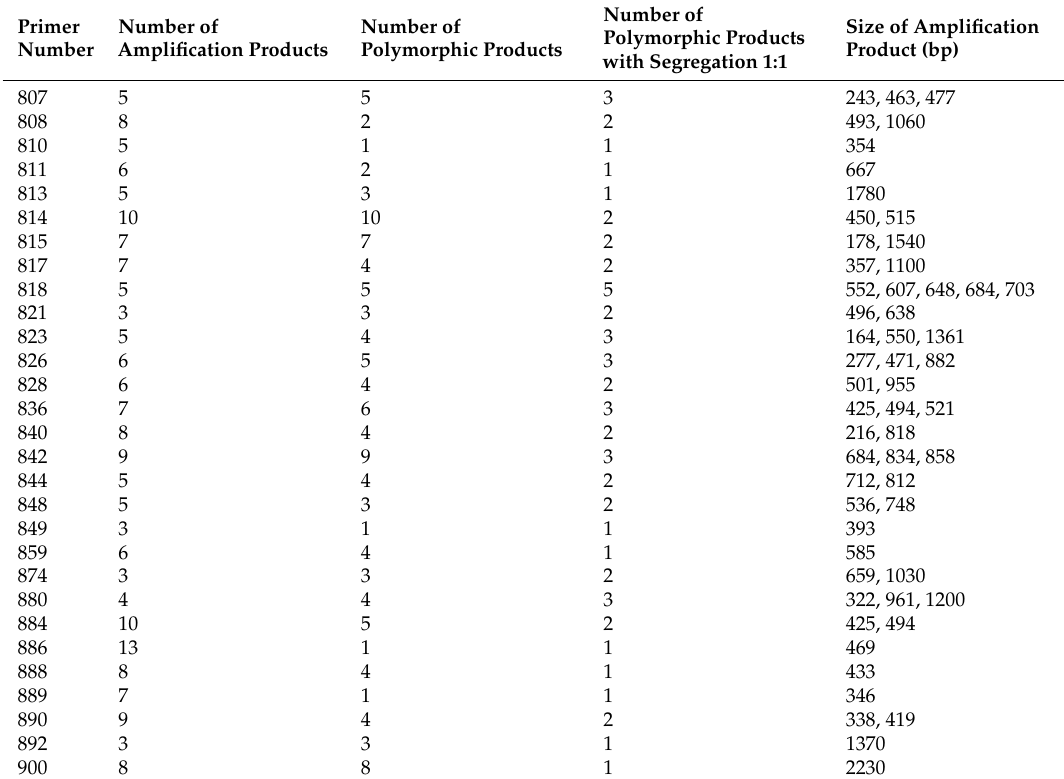
Table 1. Results of genotyping RIL mapping population EL with ISSR markers.